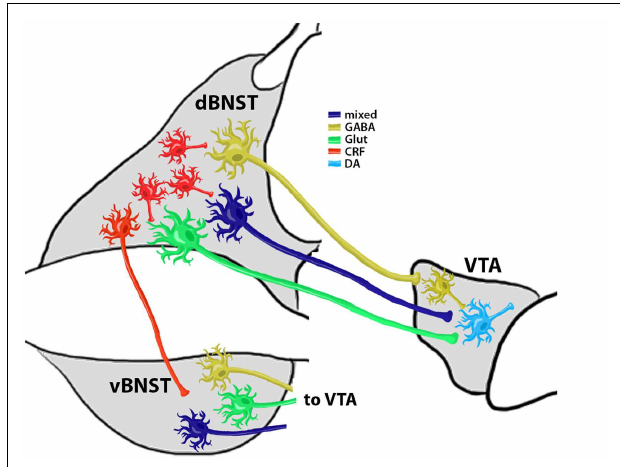
FIGURE 2 | Summary Model of Reinstatement Related BNST andVTA Connectivity . CRF + neurons modulate the activity ofVTA-projecting BNST neurons. Evidence (Kudo et al., 2012) shows that at least three types of VTA-projecting neurons are located in the BNST: (1) a GABAergic projection ( ∼ 90% of all BNST projection neurons) that selectively innervatesVTA GABA neurons to provide disinhibition ofVTA DA neurons; (2) a glutamatergic (Glut) projection that selectively targetsVTA DA neurons; and (3) a mixed GABA/Glut projection that also targetsVTA DA neurons.These projection neuron populations may exist in both the dorsal and ventral BNST subregions (d and vBNST, respectively) and each projection pathway may have distinct and coordinated responses to chronic drug exposure, withdrawal, and reinstatement. Coordinated activity of dBNST and vBNST projection neurons is likely regulated by dBNST interneurons, of which CRF + neurons may be a critical component.This local CRF neuron coordination of BNST activity might also be altered by chronic exposure and withdrawal and may be an important target for the prevention of relapse-like